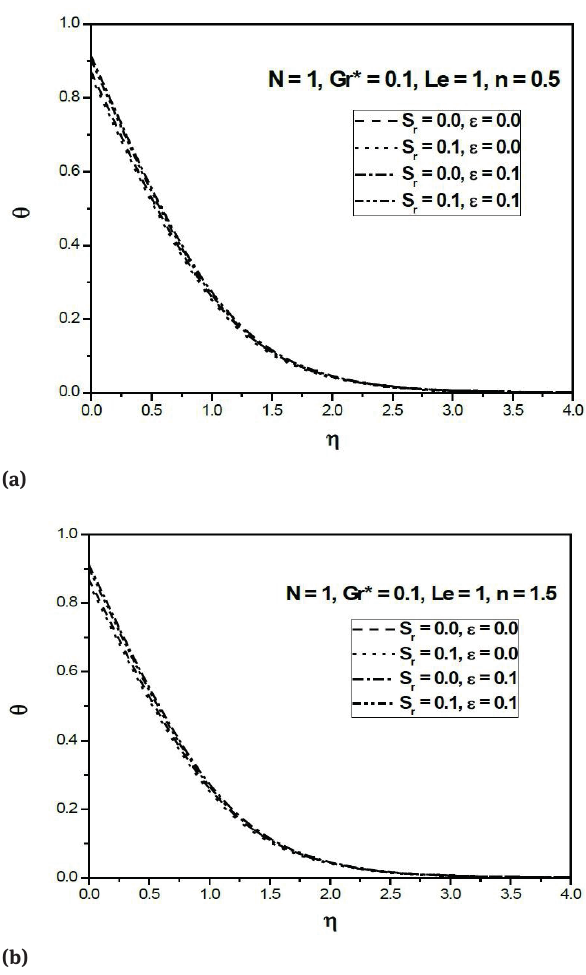
Fig. 2: (a) Variation of temperature profiles against η for n = 0.5 (Aiding Buoyancy); (b) Variation of temperature profiles against η for n = 1.5 (Aiding